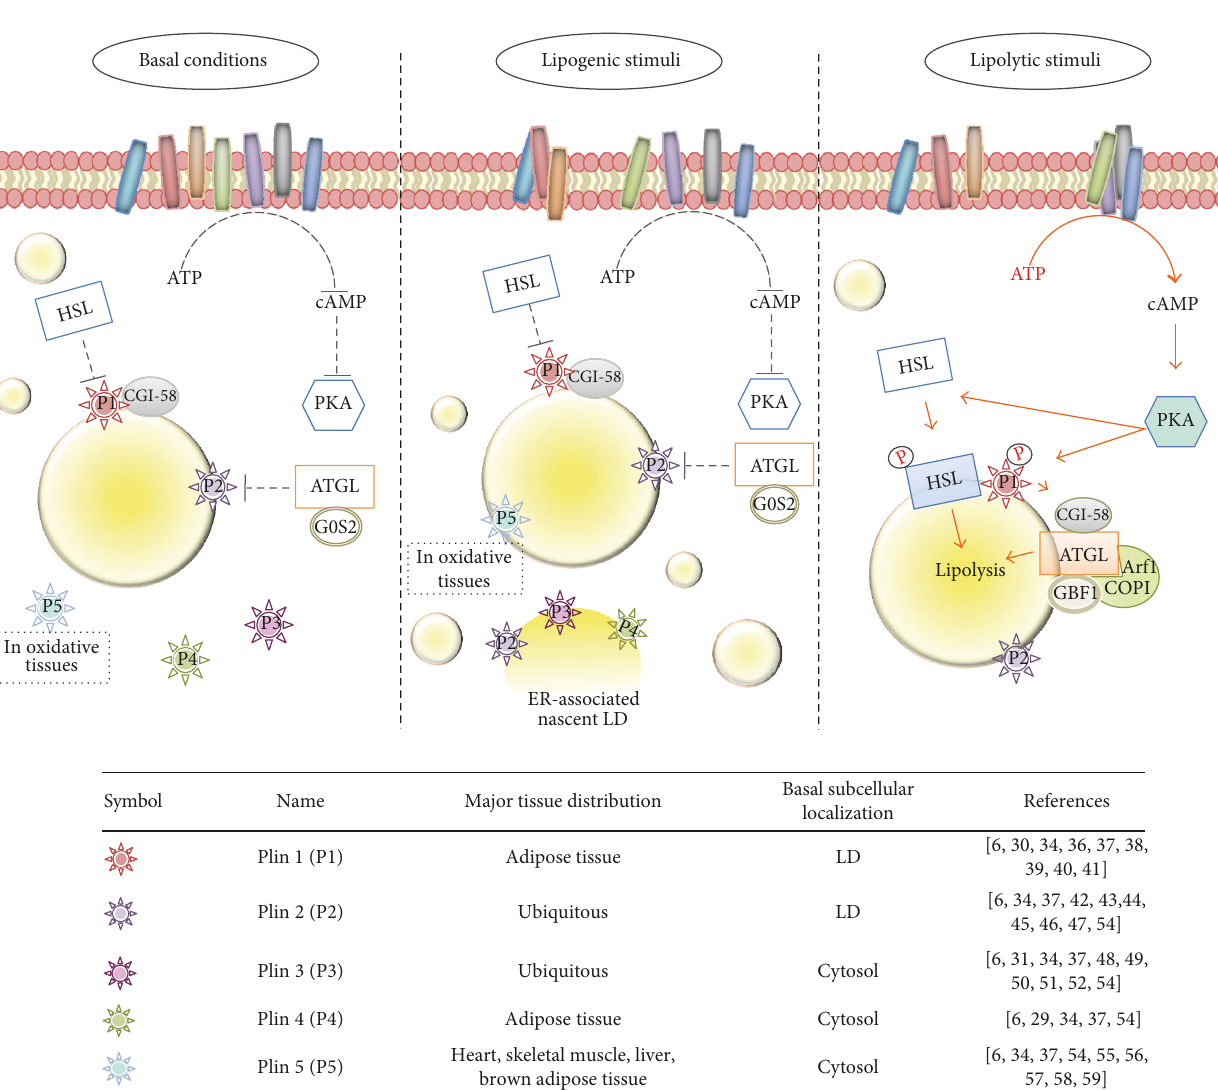
Figure 3: Schematic model representing the mechanisms of PLIN1 and PLIN2 action and PLIN3, PLIN4, and PLIN5 localization. In basal conditions (left panel), PLIN1 forms a complex with CGI-58, while ATGL association with G0S2 impairs the enzyme activity. PLIN1 and PLIN 2 block the LD access to lipases, and only a low rate of lipolysis takes place. Under lipogenic stimuli or FA surplus (central panel), PLIN2, PLIN3, and PLIN4 localize on nascent LDs at ER. Lipolytic stimuli (right panel), such as β -adrenergic stimulation, activate PKA via increased levels of cAMP. PKA phosphorylates PLIN1 and HSL, inducing HSL translocation to LD surface and release of CGI-58. This latter can form a complex with ATGL, whose activity also requires the binding with GBF1 factor and with Arf/COPI complex resulting in activated lipolysis. GBF1: Golgi brefeldin A resistance guanine nucleotide exchange factor 1; G052: 33mer gliadin peptide; CGI-58: comparative gene identi fi cation-58; P1: perilipin 1; P2: perilipin 2; P3: perilipin 3; P4: perilipin 4; P5: perilipin 5; PKA: protein kinase A; Arf1/COPI: ADP ribosylation factor/coat protein